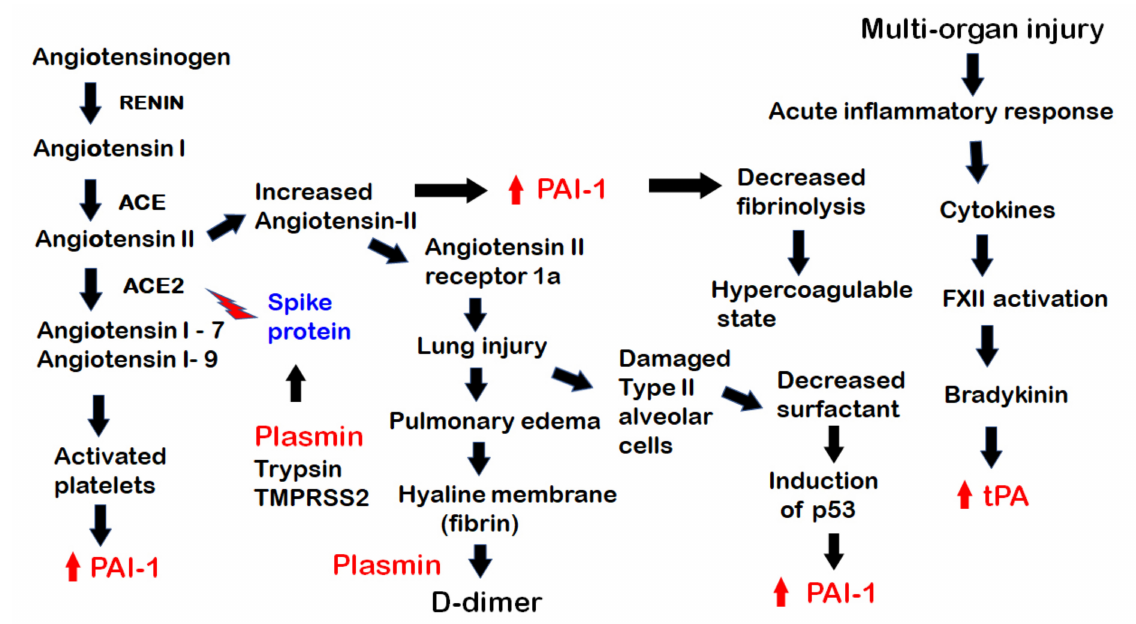
Figure 2. The pathogenesis of COVID-19, showing the involvement of components of the fibrinolytic system in various steps. From the left, the renin-aldosterone-angiotensin-system (RAAS) pathway is shown. Plasmin and other proteases, trypsin and TMPRSS2 act on the SARS-CoV-2 spike protein to facilitate its binding to ACE2 on the surface of host cells. With the binding, the virus invades the host cells while ACE2 is internalized and unable to process the breakdown of angiotensin II, leading to its excess. The excess of angiotensin II leads to an increase in PAI-1 and decreased fibrinolysis, creating a hypercoagulable state, while the excess of angiotensin II binds to its receptor angiotensin II receptor 1a, causing lung injury and leading to pulmonary edema with the formation of a hyaline membrane with fibrin in the alveoli. This is broken down by plasmin with the formation of D-dimer. The diffuse alveolar damage with damaged type II alveolar cells leads to decreased surfactant, which results in induction of the p53 pathway and increased in PAI-1. Of note (on the left), platelets are activated by angiotensin 1–9 and by other pathways. They then release PAI-1 into the circulation. There is also an acute inflammatory response with multi-organ injury. Inflammatory cytokines activate factor XII leading to bradykinin formation and a subsequent increase in